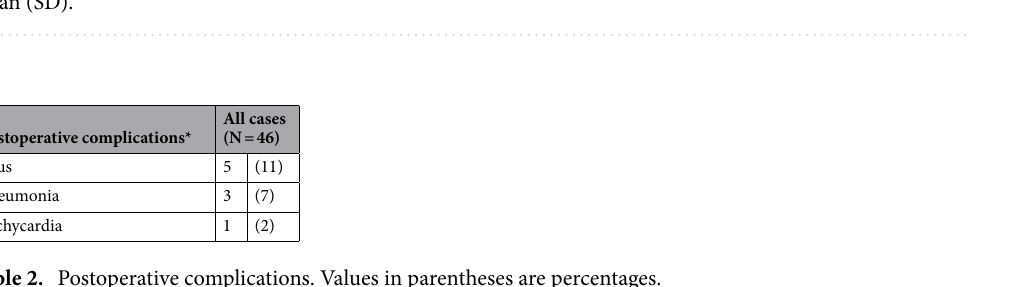
Table 2. Postoperative complications. Values in parentheses are percentages.